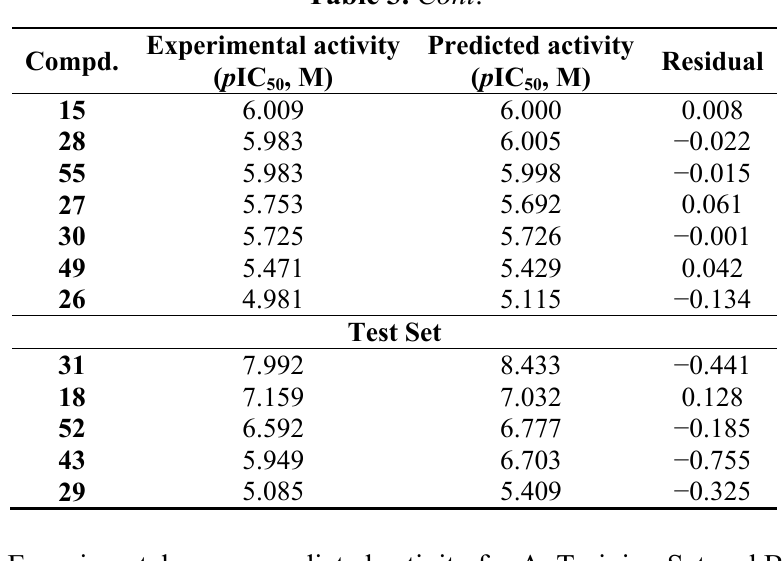
Figure 7. Experimental versus predicted activity for A. Training Set and B. Test Set.